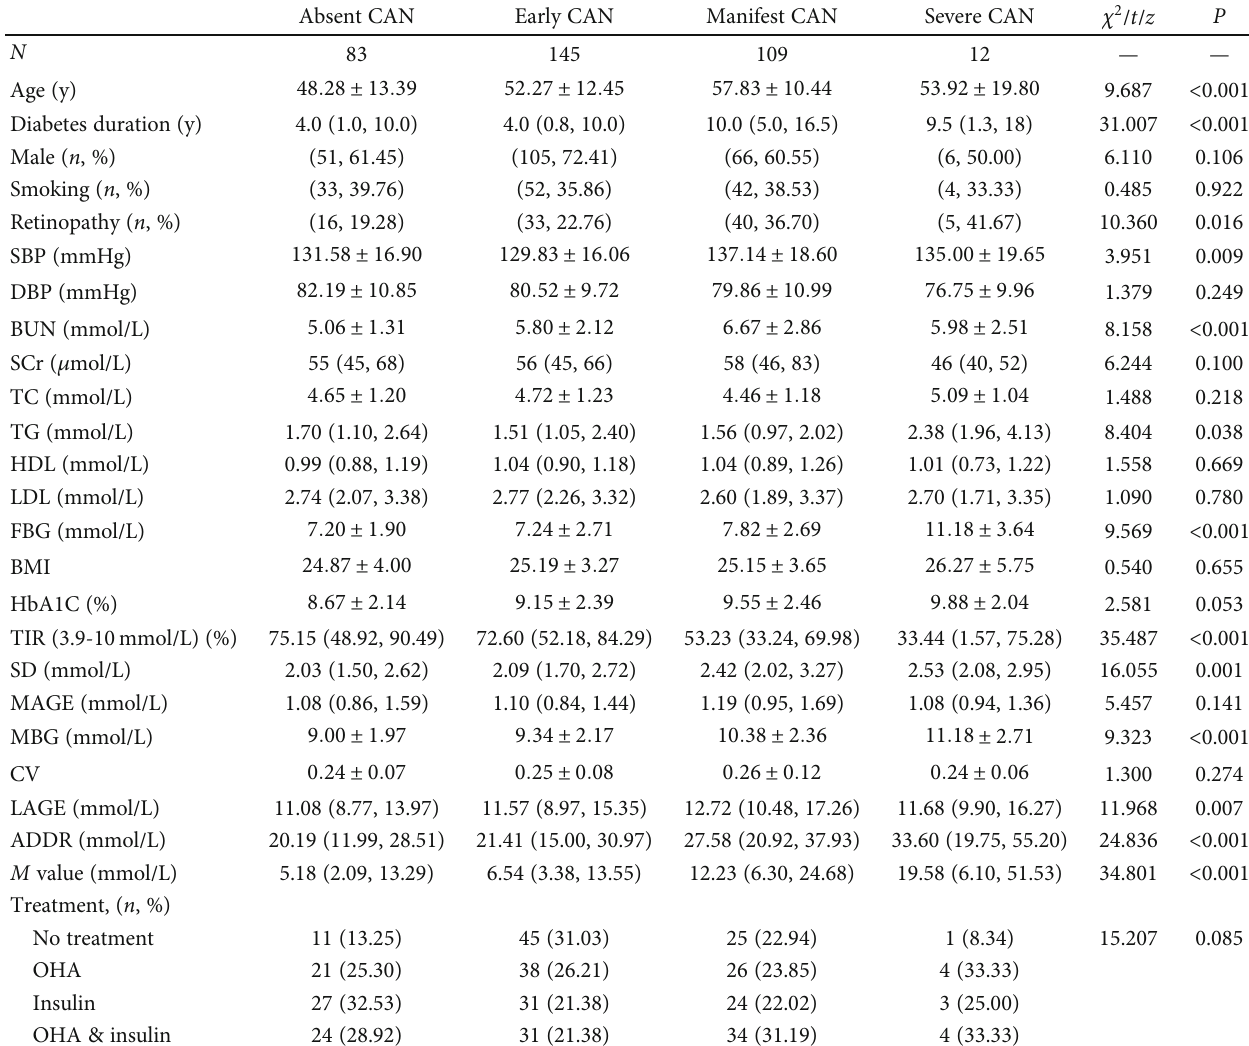
Table 1: The Clinical characteristics among every stage of CAN